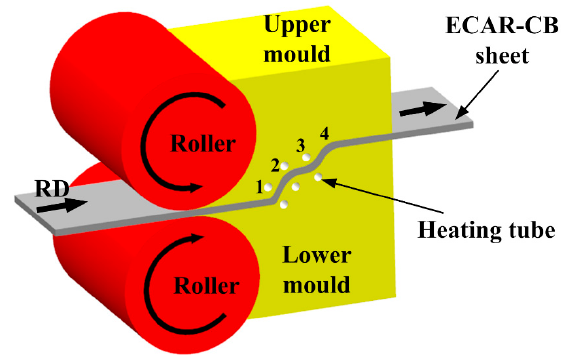
Figure 1. Schematic illustration of the equal channel angular rolling and continuous bending (ECAR-CB) process: shear deformation in corner 1 and bending deformation in corners 2, 3 and 4.